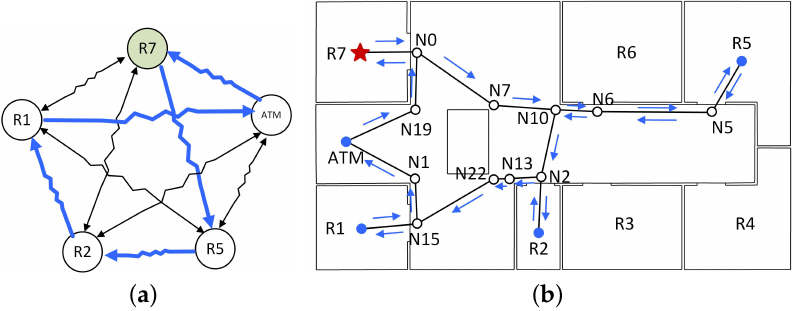
Figure 3. The result of TSP and the optimal navigation path of ITSP. ( a ) Results of sorted paths. ( b ) The navigation path of